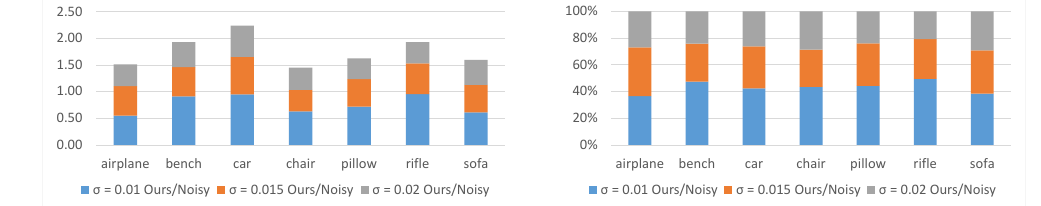
Figure 7. Error analysis for the normalized C2C scores. Left image explains the cumulative error, while the right one shows the weights of the errors for low-, mid-, and high-level